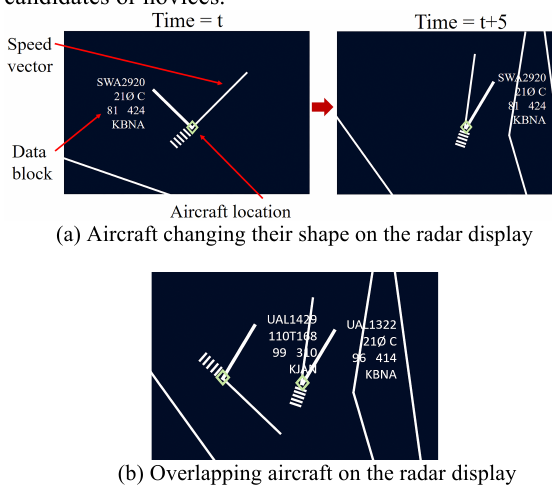
Figure 1: Dynamic aspects of aircraft representation on the radar display of an ATCS: (a) Location of the data blocks changes relative to the aircraft location. (b) Two overlapping